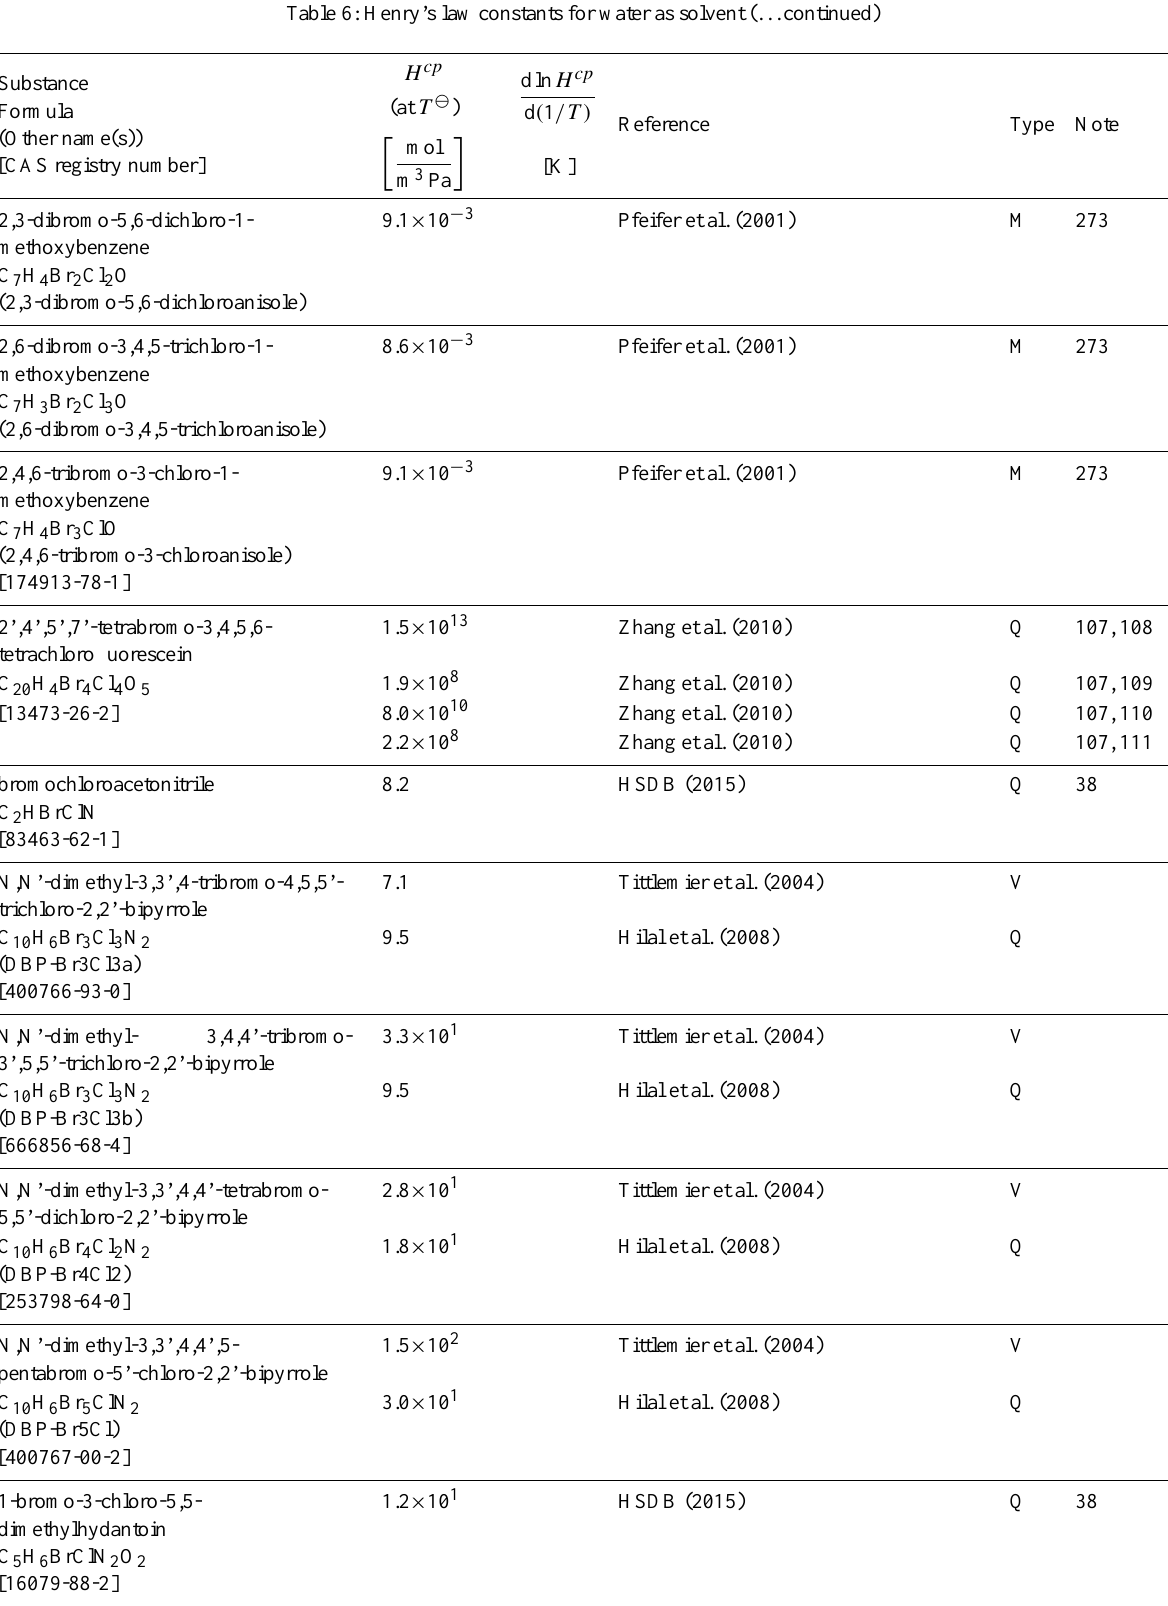
Table 6: Henry’s law constants for water as solvent